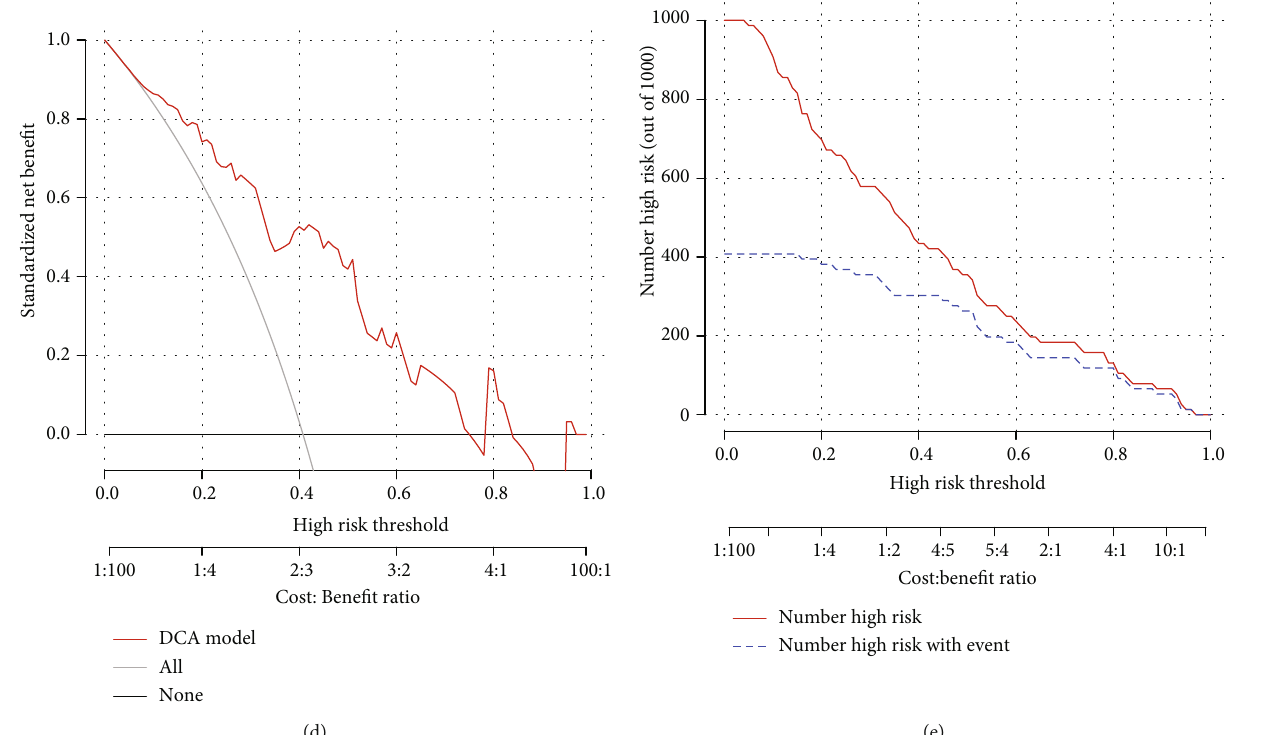
Figure 3: E ffi ciency and validation of the activity diagnosis model. (a) ROC of activity model in di ff erentiating active SLE from inactive ones. (b) Calibration curve of activity model. (c) Nomogram of activity model with TNF RII, BLC, and MIP-1b. (d) Decision curve for the activity model in predicting active lupus. The red line represented activity model, grey line represented the assumption that all patients su ff ered active lupus, and black line represented the assumption that all patients had inactive lupus. (e) Clinical impact curve analysis diagram. Red line represented number of patients which were diagnosed with active lupus by our model at di ff erent threshold probability, and blue line represented number of patients with active